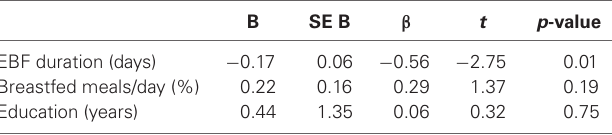
Table 2 | Multiple regression indicating a positive prediction of EBF duration on the Nc in response to fearful expressions minus Nc in response to happy expressions .